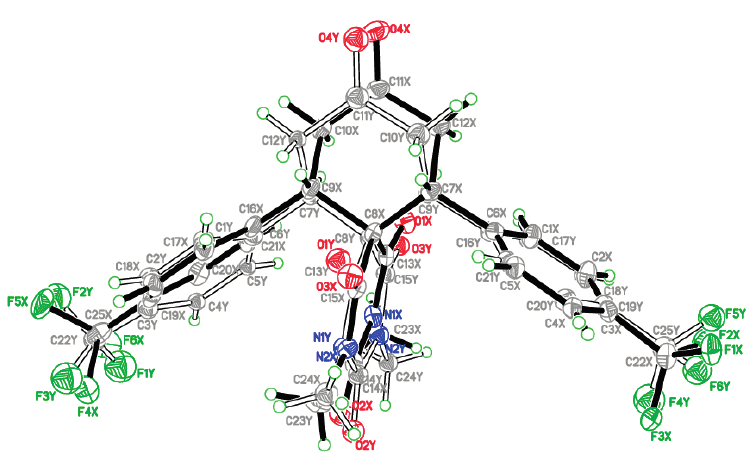
Figure 4. The ORTEP diagram of the final X-ray model of compound 3b with full molecule